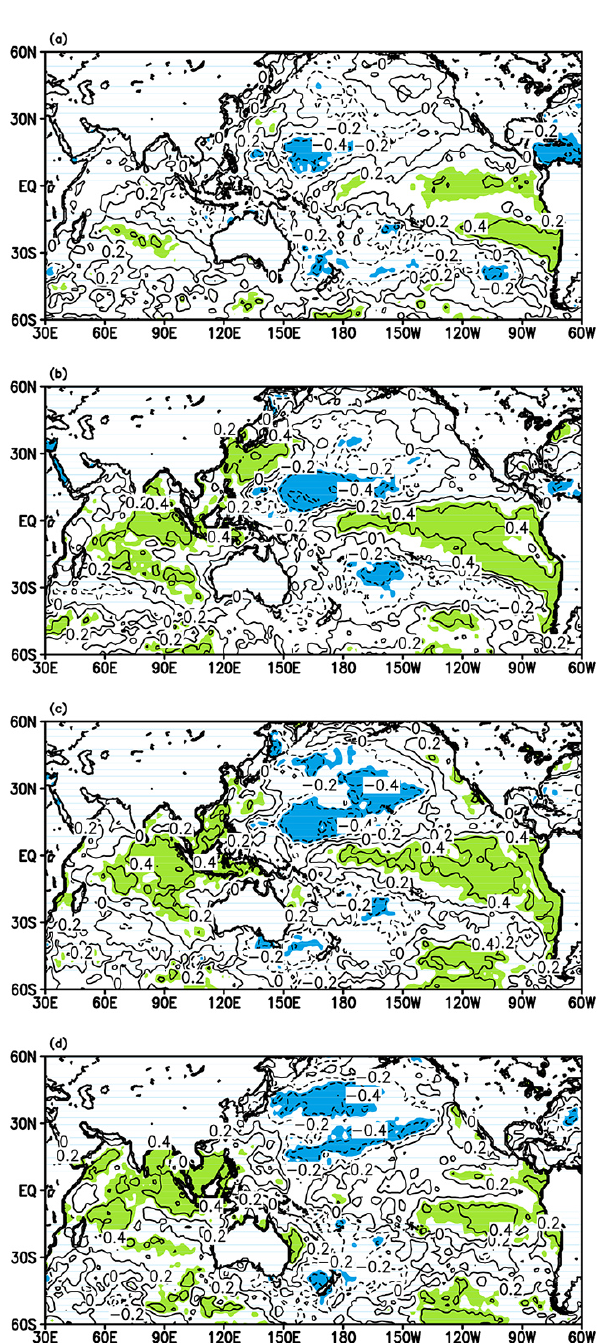
Figure 9. Correlation maps of the summer R WNP/BOB with the SST in the previous autumn (September-October-November) (a) , winter (December-January-February) (b) , spring (March-April-May) (c) , and concurrent summer (June-July-August) (d) for 1960–1994. The shaded area is above the 95% confidence